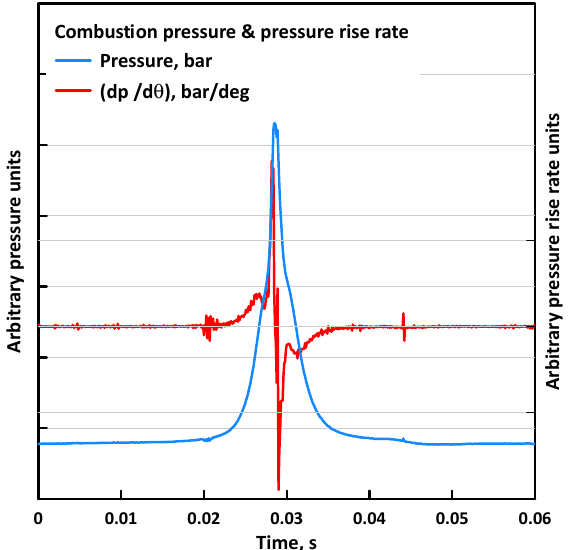
Figure 10. Typical combustion pressure and pressure rise rate (for Jojoba fuel, N = 1950 rpm).